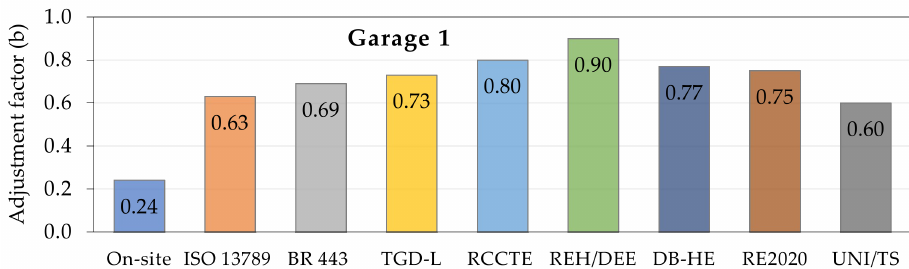
Figure 20. Comparison of the adjustment factor values (b) for Garage 1.